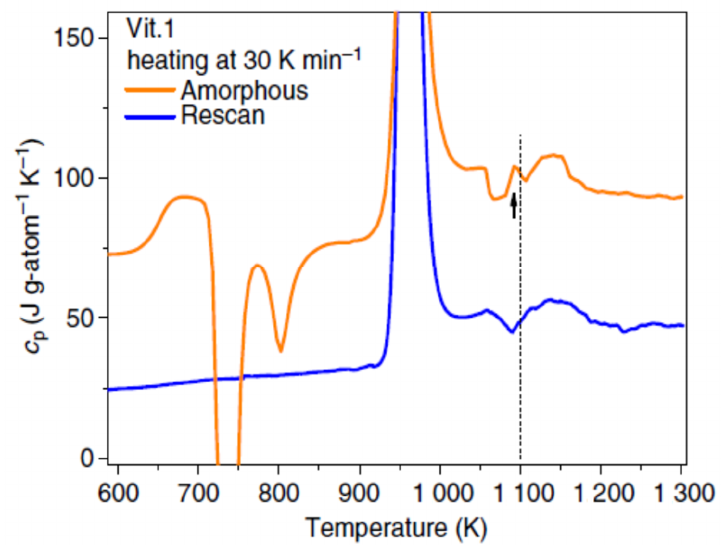
Figure 7. C p measured upon heating at 30 K/min for the amorphous sample (upper) and once-melted crystallized sample (lower) (vertically shifted for clarity). Reprinted from ref. [45], Figure 1b.